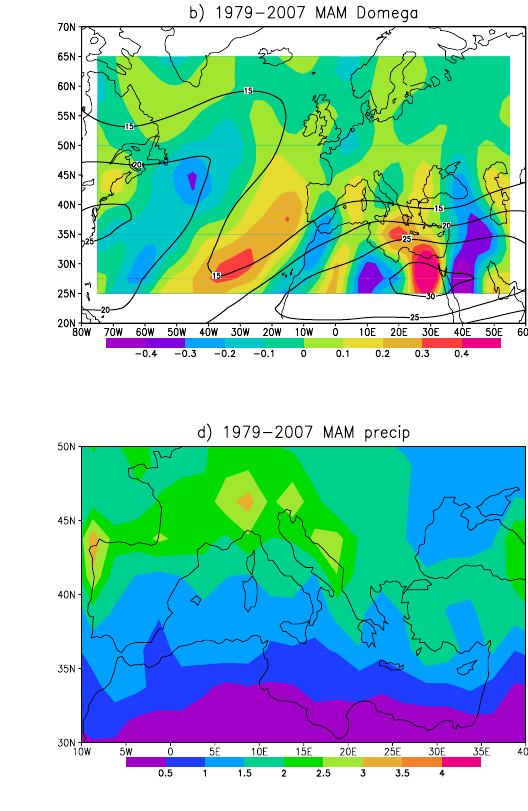
Fig. 9. Same as Fig. 5, but for spring.